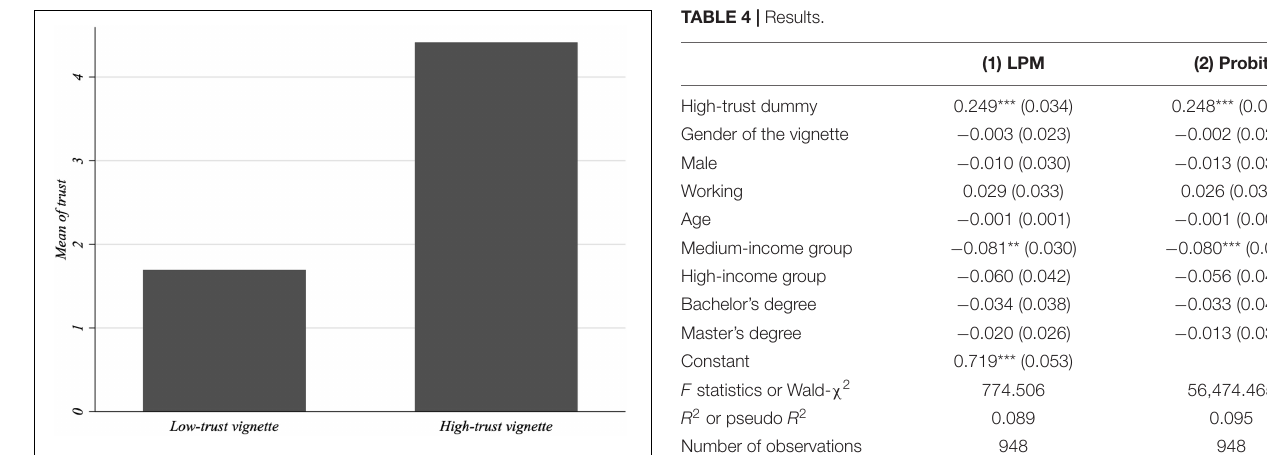
Frontiers in Psychology |